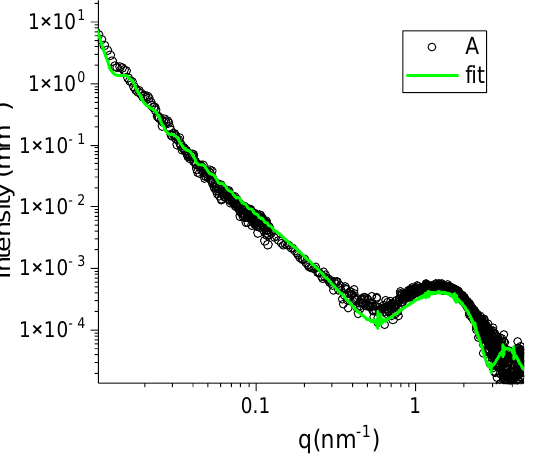
Figure 1. SAXS spectrum of empty niosomes, sample A (22.5 mM, room temperature, open dots) reported in log-log scale. The green line is the best fit.